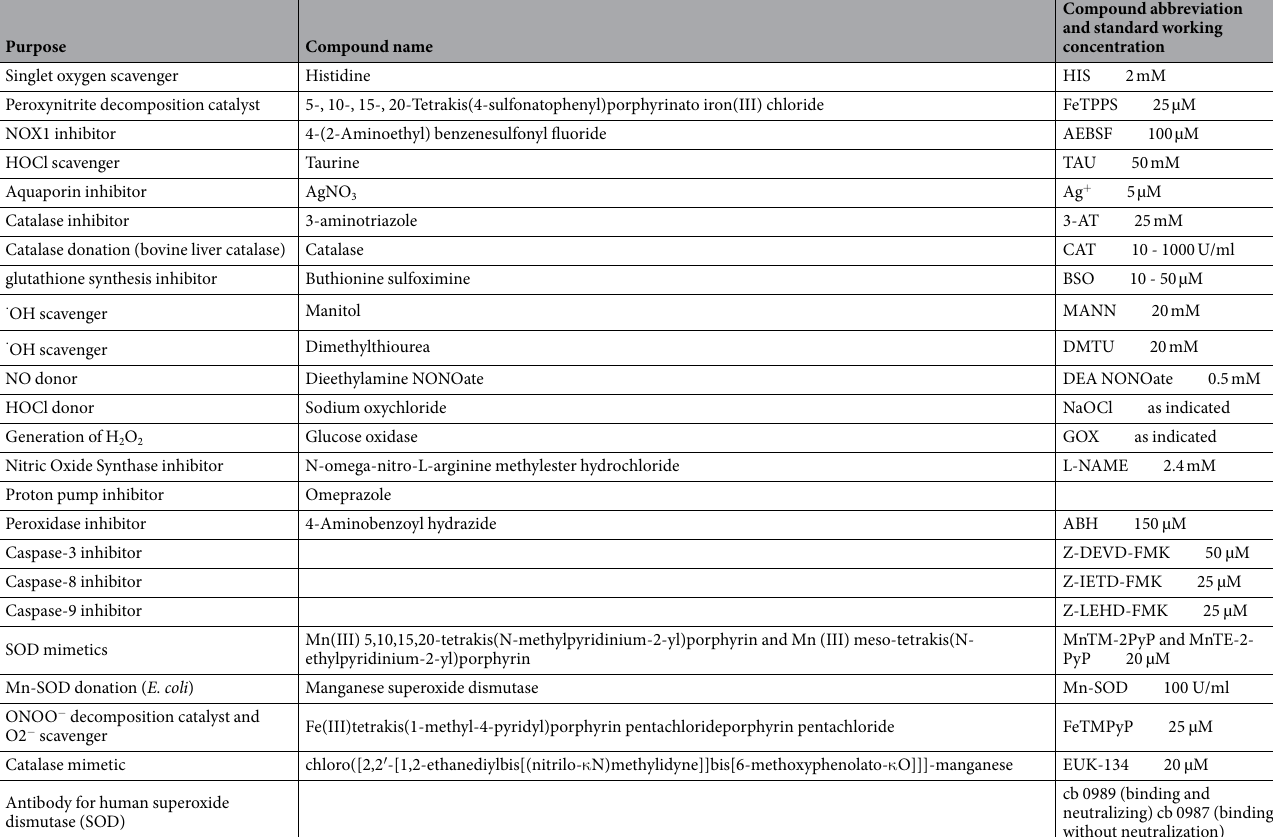
Table 1. Summary of enzyme inhibitors, reactive species scavengers, reactive species donors, mimetics, and antibodies used in the present study to elucidate apoptotic and protective